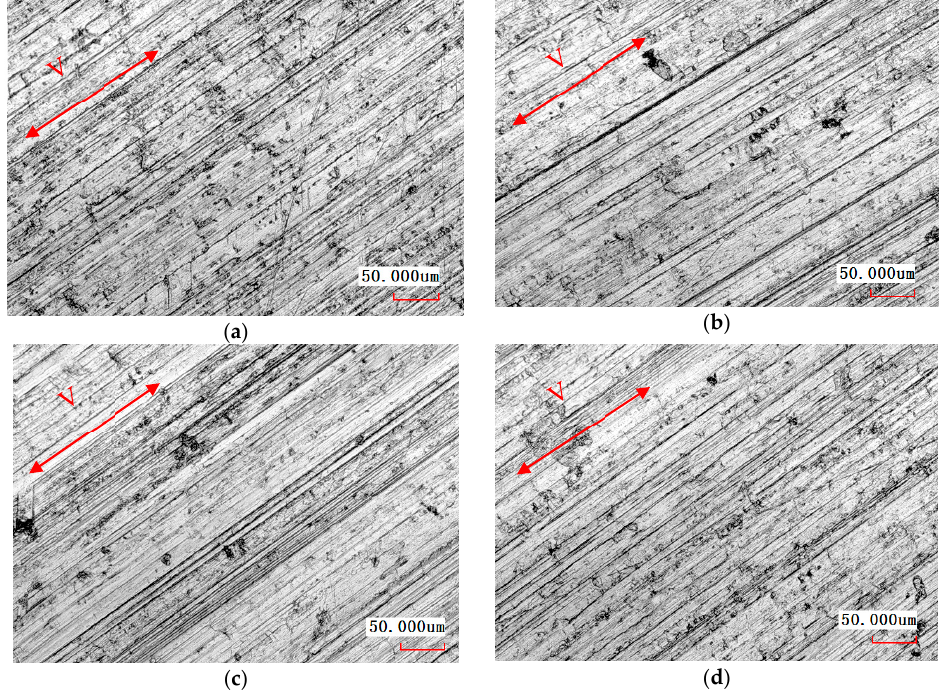
Figure 8. Surface morphology under different normal loads: ( a ) 10 N; ( b ) 20 N; ( c ) 40 N; ( d ) 50 N.